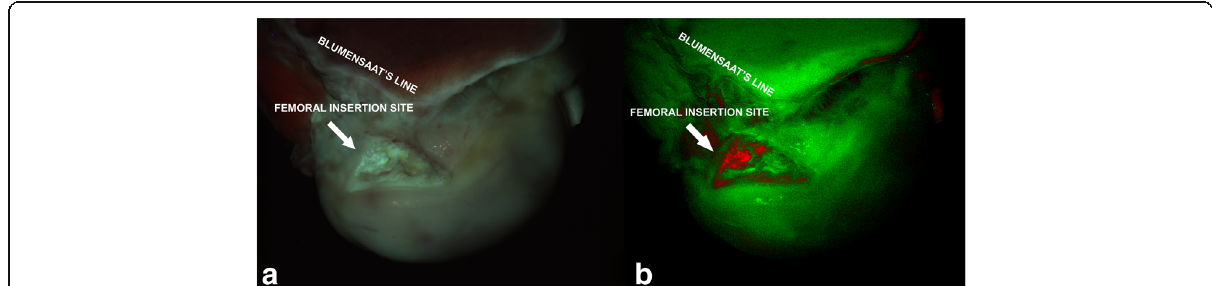
Fig. 4 a : Bovine lateral femoral condyle in grayscale. ACL is indicated by arrow. It has to be noted that the insertion site can be easily seen in this macroscopic and sagittal section, however this is difficult when viewed arthroscopically. b : False color image of the same bovine lateral femoral condyle with femoral insertion site. Notice how the other ligaments are also enhanced by the method The Dice coefficients of the white light images vs unmixed images and the white light interobserver Dice were not statistically different ( p = 0.57). The same holds for white light images vs unmixed images and the unmixed interob- server Dice ( p = 0.56) and the white light images interob- server vs unmixed images interobserver Dice ( p = 0.20).